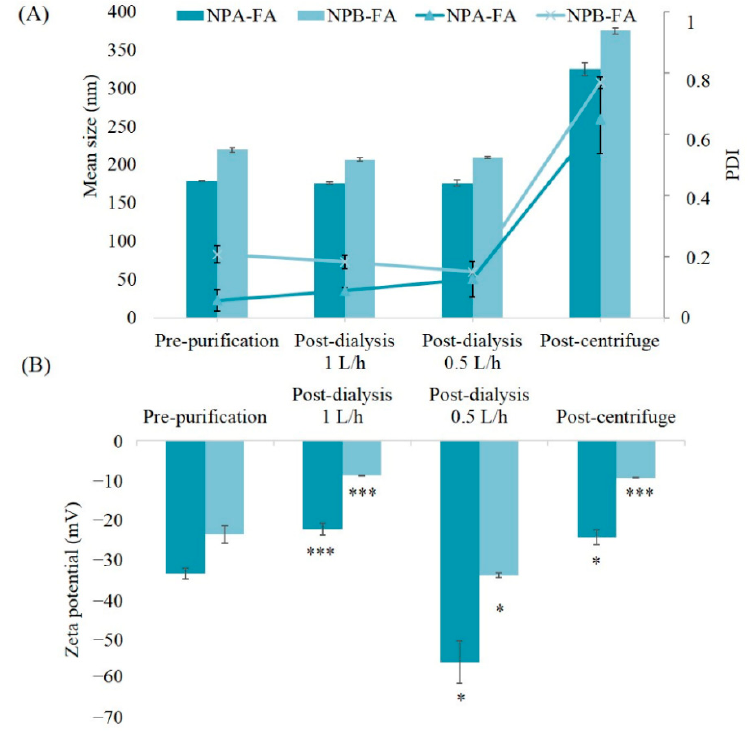
Figure 2. Mean size, PDI ( A ) and zeta potential ( B ) of the samples NPA-FA and NPB-FA. t -test was used to calculate statistical significance of the percentages obtained versus control group. [ns = not significant ( p > 0.05); * = significant ( p < 0.05); *** = extremely significant ( p < 0.001)].